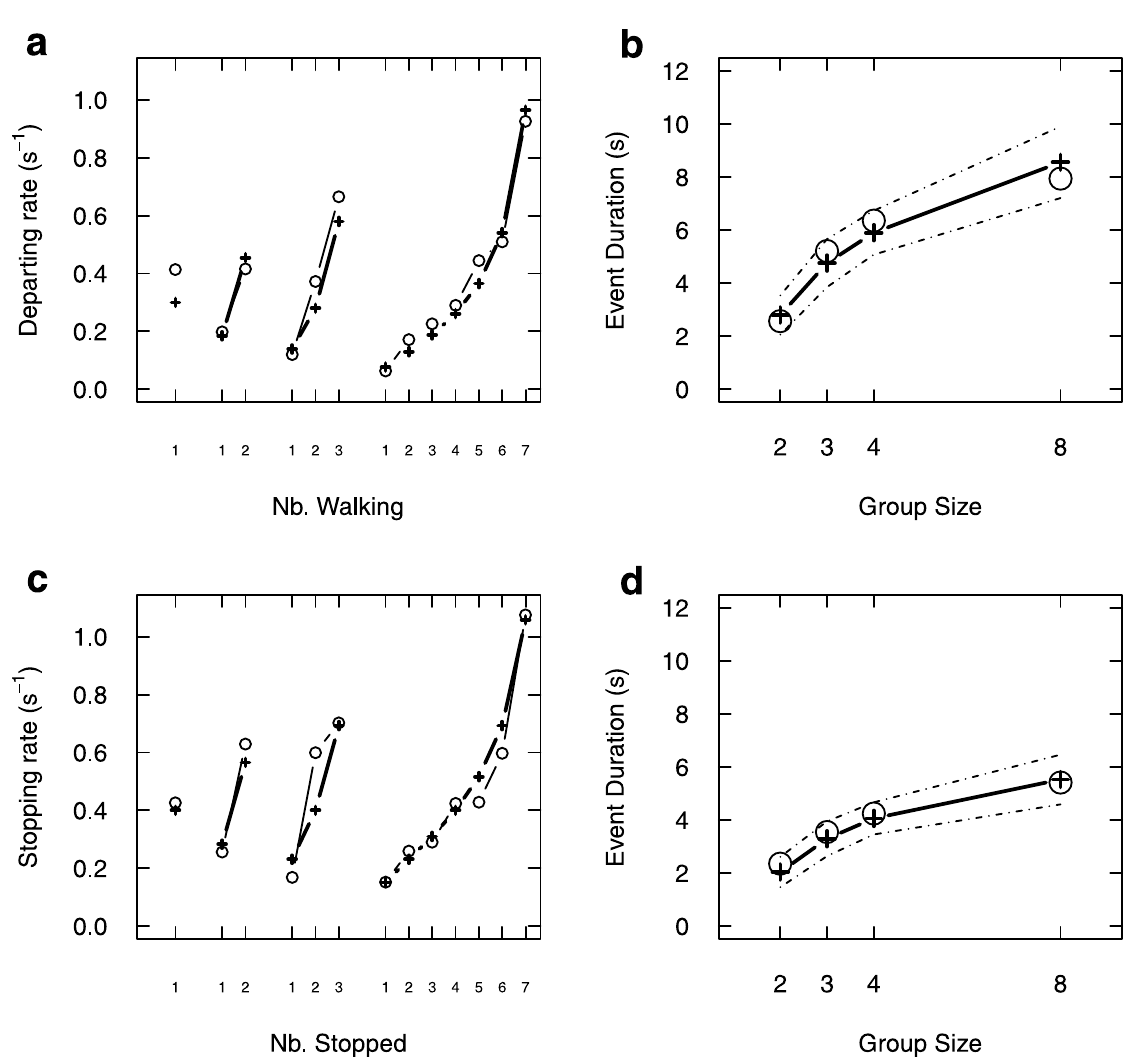
Fig 2. Mimetic amplification governs individual transition rates. (a) For each group size (2,3,4,8), we report the individual transition rate from stopped to moving as a function of the number of individuals moving ahead. This rate increases, indicating that individuals moving ahead have a positive feedback effect upon the propensity to follow them (stimulating effect). Note that, for a given number of departed individuals (e.g. 1), the rate decreases with group size, indicating an inhibitory effect of other individuals. Open circles: data, crosses: fitted rates. (b) For each group size, simulating collective departures using the fitted transition rates yields a correct prediction of the average event duration, from first start to last start, as a function of group size (10000 simulated events, dotted lines indicate 95% CI of the mean). (c) Same kind of data and fitted rates, but for the moving-to-stopped rates. While en route, stopping rates are positively enhanced by the number of individuals stopped behind (stimulating effect), together with a inhibitory effect of the others. (d) Events simulations also confirm that the fitted stopping rates yield correct predicted average event duration, from first stop to last stop, as a function of group size. Fitted parameters are indicated in Table 1.